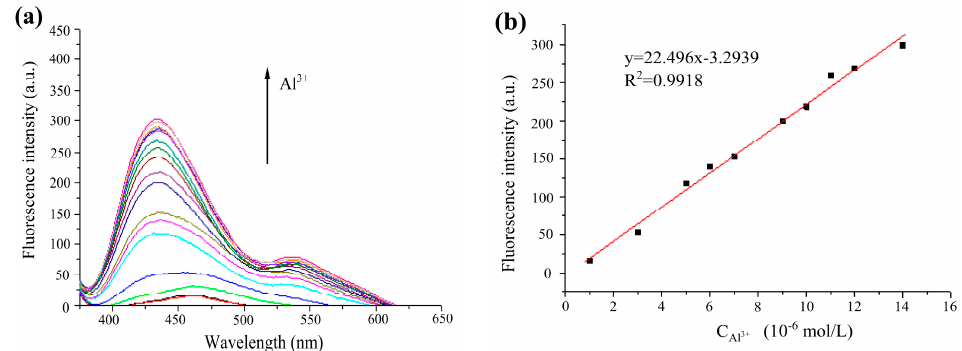
Figure 4. ( a ) Fluorescence spectra of F6 combined with Al 3+ at different concentrations; ( b ) standard curve for the detection of Al 3+ by fluorescence probe F6.